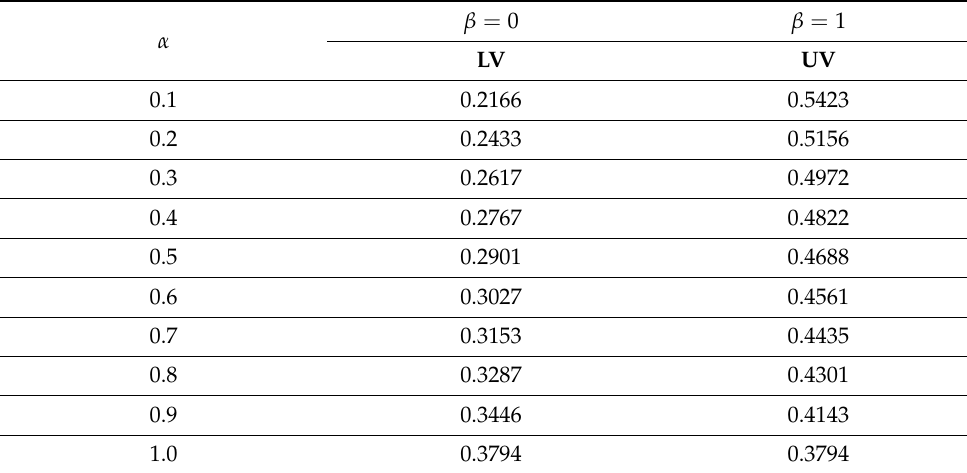
Table 5. Fuzzy solution of η for h = 0.1 at t = 1.5 s.